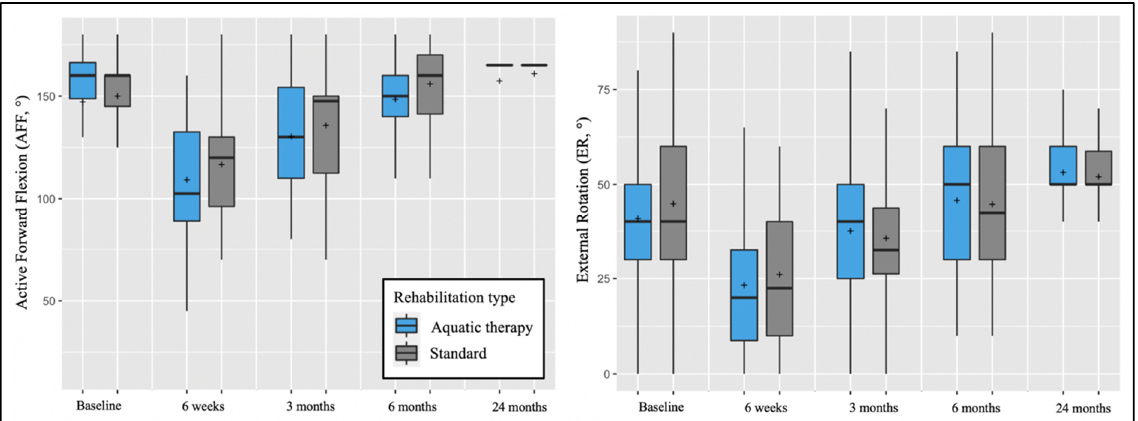
Figure 4. Pre-operative and post-operative active forward flexion (AFF) and external rotation (ER) depending on post-operative rehabilitation (Aquatic therapy vs. standard). The plots illustrate median values (bold lines), means (+), interquartile ranges (boxes), and 95% CIs (whiskers). At two post-operative years, the two groups had comparable ASES ( p = 0.864) and SST scores (0.846). There were also no statistical differences in workstop duration ( p = 0.580), satisfaction scores ( p = 0.663), or tendon healing rate ( p = 0.443) (Table 3). Complications were noted for three patients in the standard group vs. one in the aquatic therapy group (7.3% vs. 2.8%, p = 0.349). The complications in the aquatic therapy group included